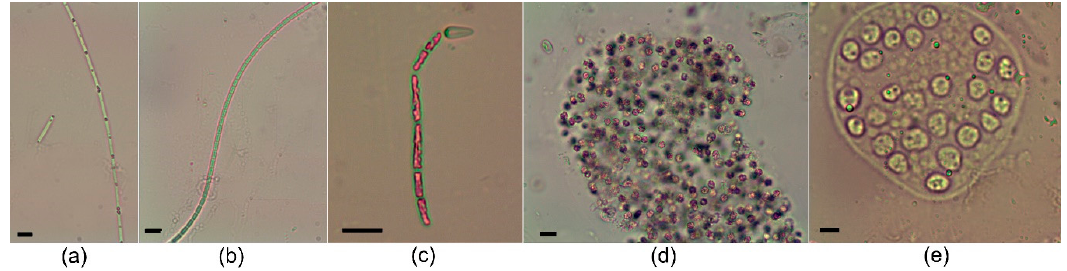
Figure 2. Dominant cyanobacterial species from Lake Ludoš in 2018: ( a ) Limnothrix redekei ; ( b ) Pseudanabaena limnetica ; ( c ) Raphidiopsis raciborskii ; ( d ) Microcystis aeruginosa ; ( e ) Microcystis wesenbergii ; Scale bars: 10 μ m.